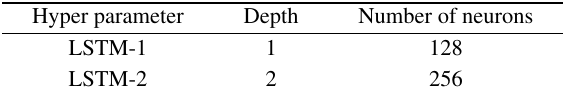
Table 3 Model configurations of recurrent neural network.